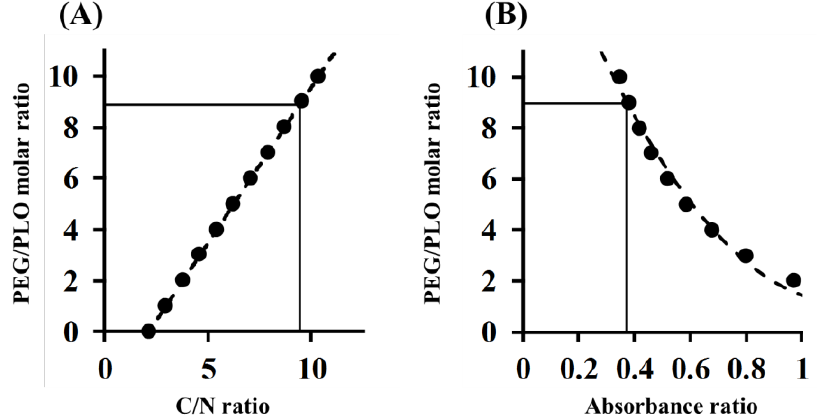
Figure 3. Determination of PEG/PLO molar ratio of PEG-PLO by elemental analysis (A); and TNBS (2,4,6-Trinitrobenzenesulfonic acid) assay (B). ● : theoretical value; : regression line.